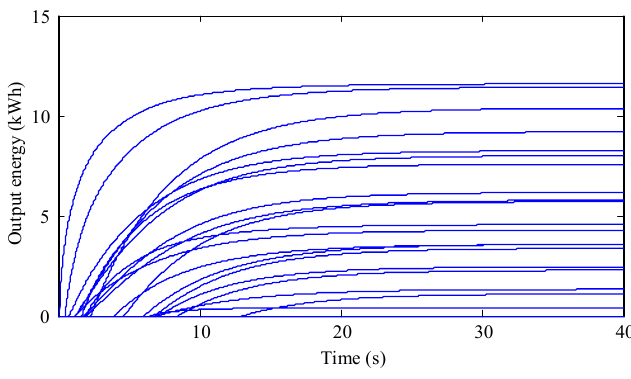
Figure 10. Output energy Q v in cluster 4.